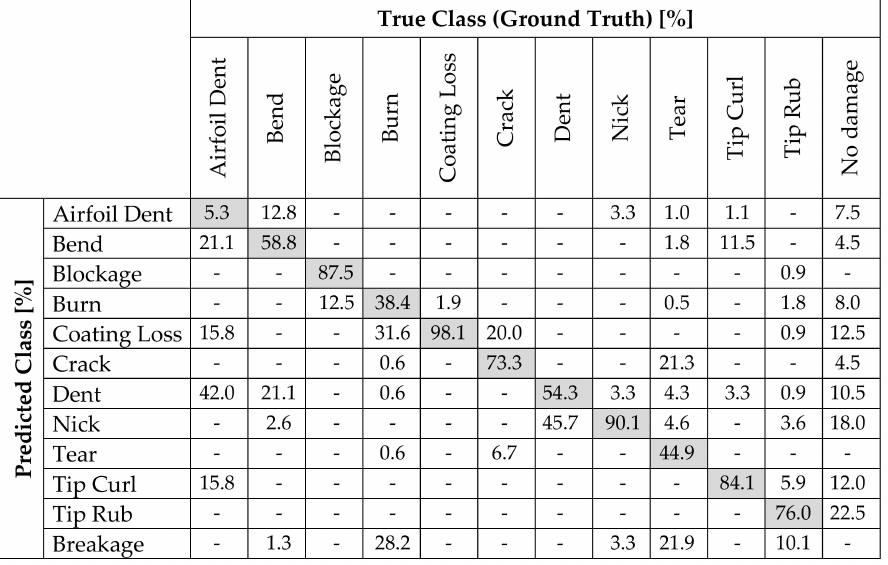
Figure 10. Classification matrix showing the distribution of defect types that are often confused.